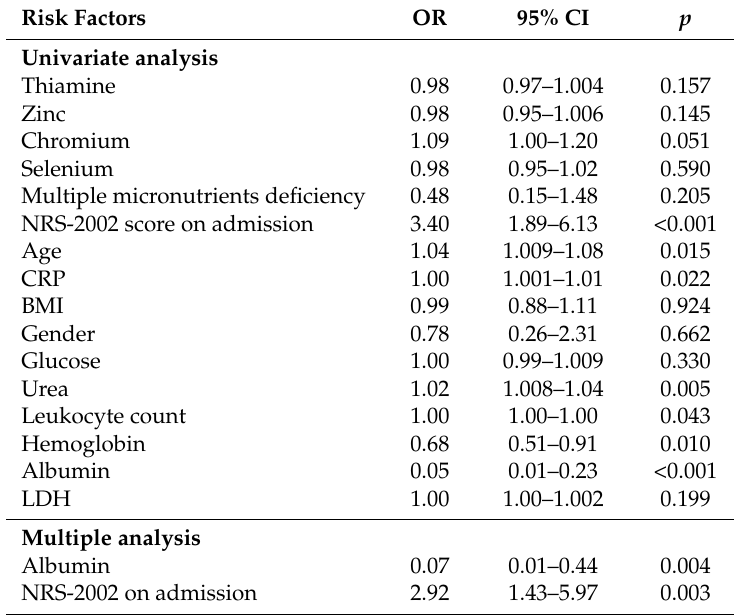
Table 4. Results of univariate and multiple logistic regression analysis for risk factors for